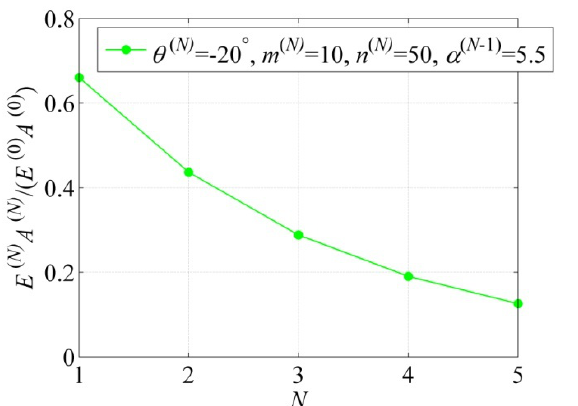
Figure 5. Schematics of the axial rigidity A vs. the hierarchical level N